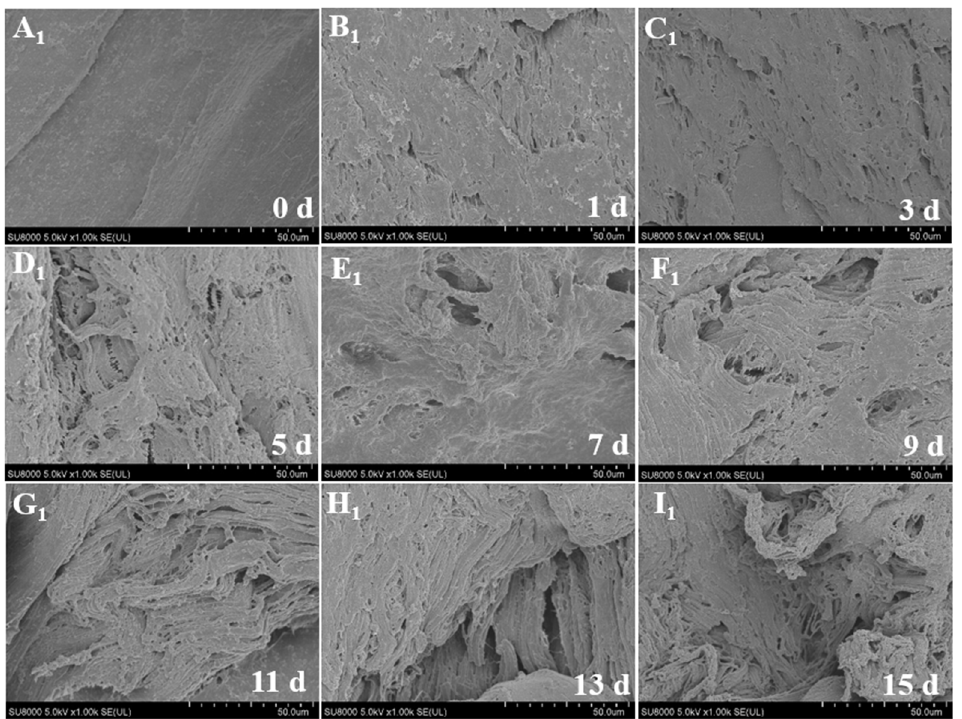
Figure 2. Changes in microstructure of Coregonus peled fillets under 4 °C refrigeration storage for 15 d. ( A 1 – I 1 ) indicate storage in 4 ◦ C refrigeration for 0–15 d.